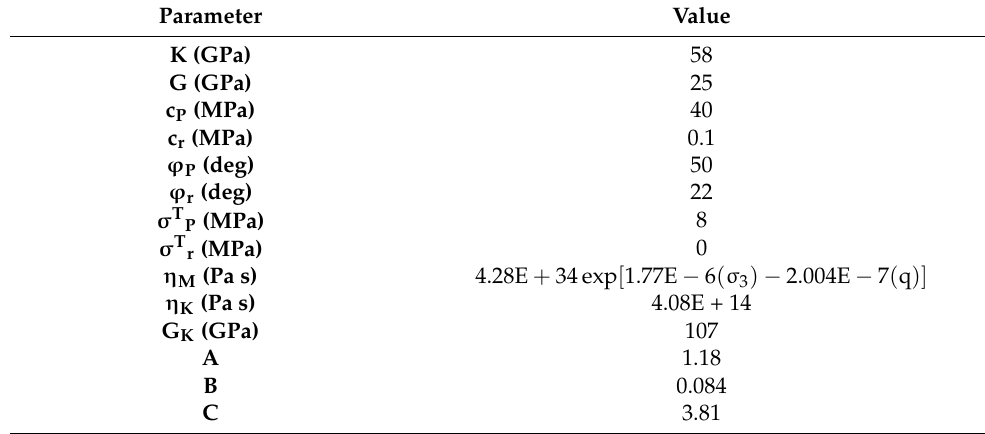
Table 3. Intact strength, long-term strength, and creep parameters for LdB granite. Peak and residual strength values calibrated from [8] and time-dependent values from [19,77]. Variables K, G, c, ϕ , σ T , and η denote bulk modulus, shear modulus, cohesion, friction angle, tensile strength, and viscosity, respectively. Additionally, subscripts p, r, M, and K denote peak, residual, Maxwell, and Kelvin, respectively. Variables A, B, and C are shown in Equation (2). Note that ‘E’ is scientific notation